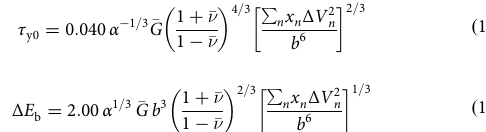
ffiffiffiffiffiffiffiffiffiffiffiffiffiffiffiffiffiffiffiffiffi p Δ V 2 ∑ n x n n